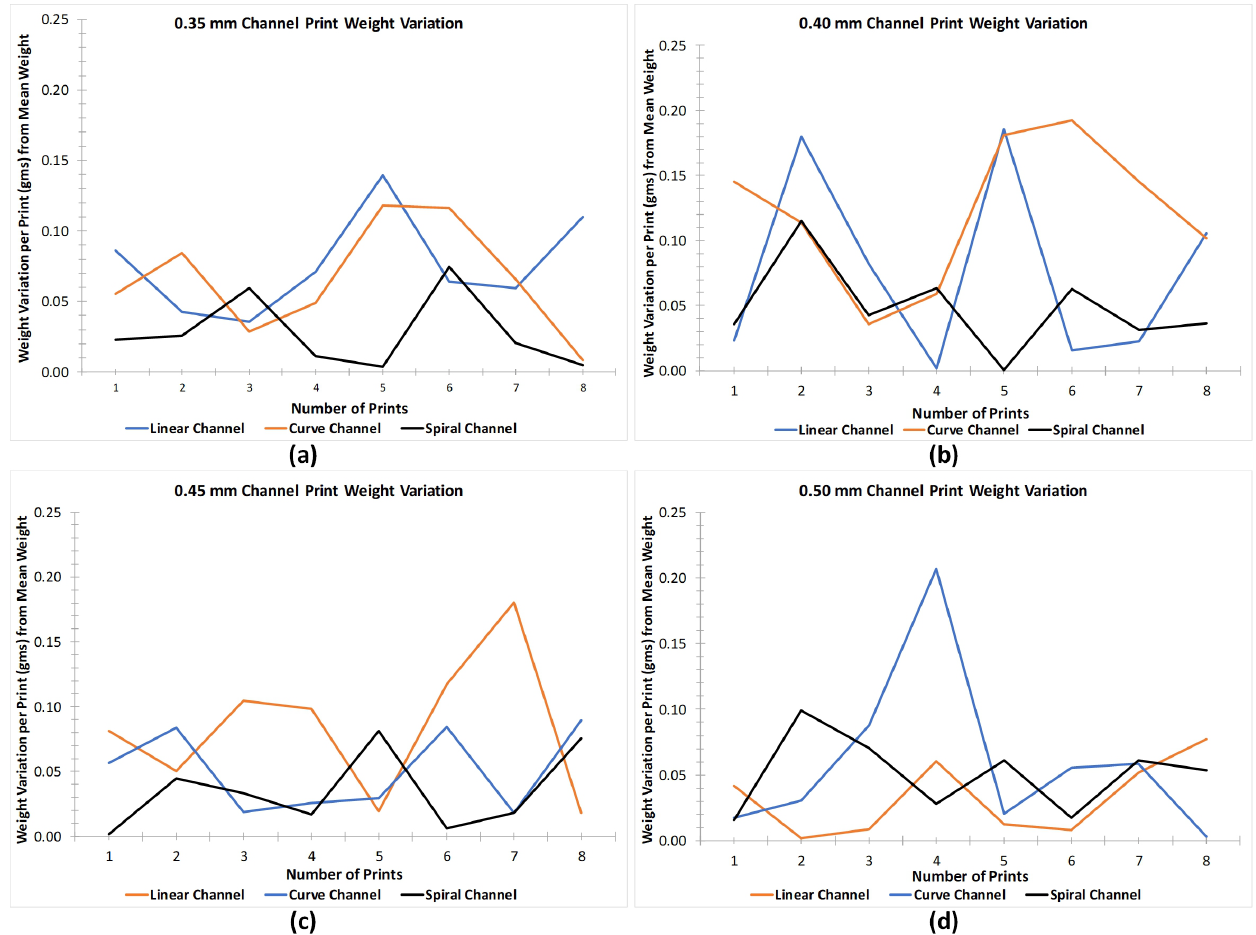
Figure 7. Weight variation of linear, curved and spiral microchannels with diameter of ( a ) 0.35 mm, ( b ) 0.4 mm, ( c ) 0.45 mm, and ( d ) 0.5 mm for 8 consecutive